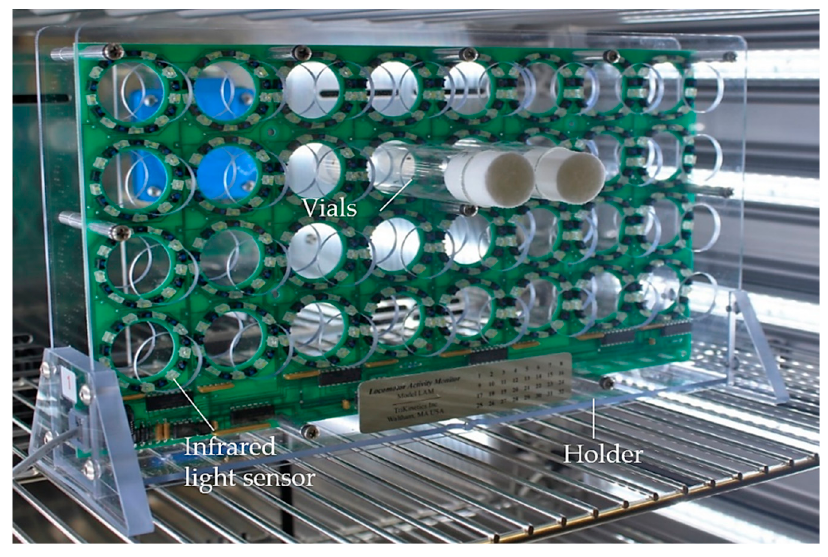
Figure 9. Drosophila Activity Monitoring (DAM) system (TriKinetics). Flies are placed in glass vials that contain experimental food and are covered with plugs. The vials are inserted horizontally into the slots of the holder of the activity monitor. In the center of each slot, an infrared light sensor is installed, which generates a signal whenever the sensor is interrupted by a crossing fly. The activity monitor is linked to a computer, and via the DAM system software, locomotion data from up to 32 vials can be recorded simultaneously (modified from